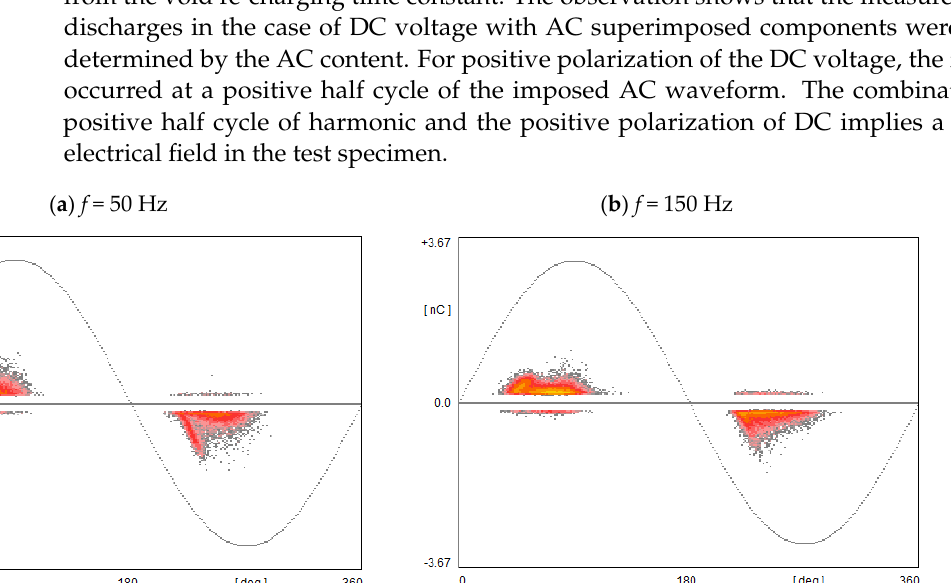
Figure 6. PRPD patterns at mixed DC 10 kV and AC 50 Hz U peak = 6 kV with frequency: ( a ) 50 Hz, ( b ) 150 Hz, ( c ) 300 Hz, ( d ) 350 Hz. 5. Conclusions This article presents investigative results of the impact of certain AC voltage harmonics on the partial discharge inception voltage. The AC harmonics can naturally appear in HVDC systems due to the working principles of the power converters. The acquisition of PDs at the DC voltage is normally performed in a time domain. A novel approach is proposed for partial discharge measurements at DC voltage, and the synchronization of measurements to the particular AC harmonic appearing in the DC waveform is introduced. This process allows accumulation of pulses originating from the PDs in HV insulation with reference to the phase of the synchronization harmonic. The synchronization signal can be taken as a voltage measured at the AC side of the power converter, the control signal from the power converter, or the filtered AC components or ripples appearing in the HVDC voltage. The filtration of the AC component allows for synchronization to the particular harmonic with consideration of its phase shift. This procedure makes it possible to measure phase-resolved PDs in DC networks. The synchronization should be made to the lowest detected harmonic to avoid mis- interpretation of the measured results caused by the fluctuation of the synchronization stamp. Based on the results of the analyses of the partial discharge measured in the dielectric sample equipped with the void, the combined DC/AC voltage was applied to the sample. The investigations revealed the impact of AC harmonics imposed in the DC voltage on the intensification of the acquired partial discharges. These events influence the technical conditions of HV insulation systems.